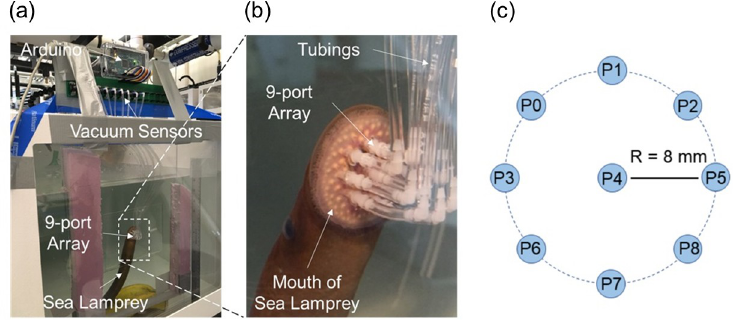
Fig 2. The 9-port circular pressure sensing system used to measure oral suction pressures of sea lamprey, Petromyzon marinus . (a) The full view of the setup, (b) enlarged view of an adult sea lamprey attached to the sensing panel with its mouth covering all the 9 sensing ports, and (c) a schematic of the 9 ports.